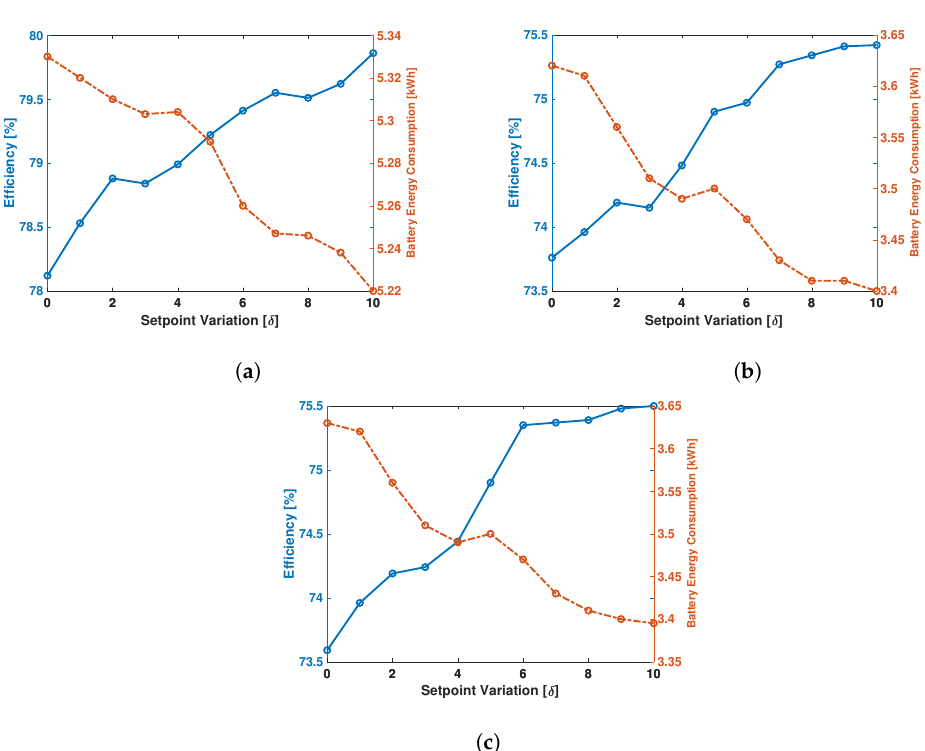
Figure 14. Result of efficiency curves based on speed ( a ) DC 1 described in Route 1; ( b ) DC 2 described in Route 2 and ( c ) DC 3 described in Route